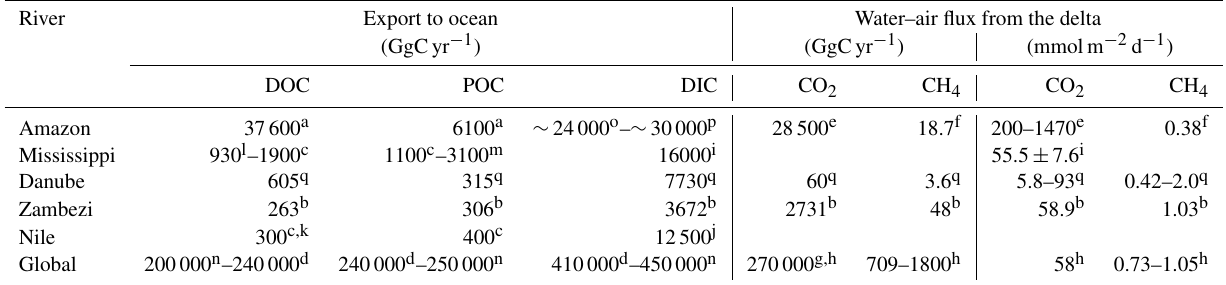
Table 3. Selected major rivers and their carbon fluxes to the ocean and atmosphere. River